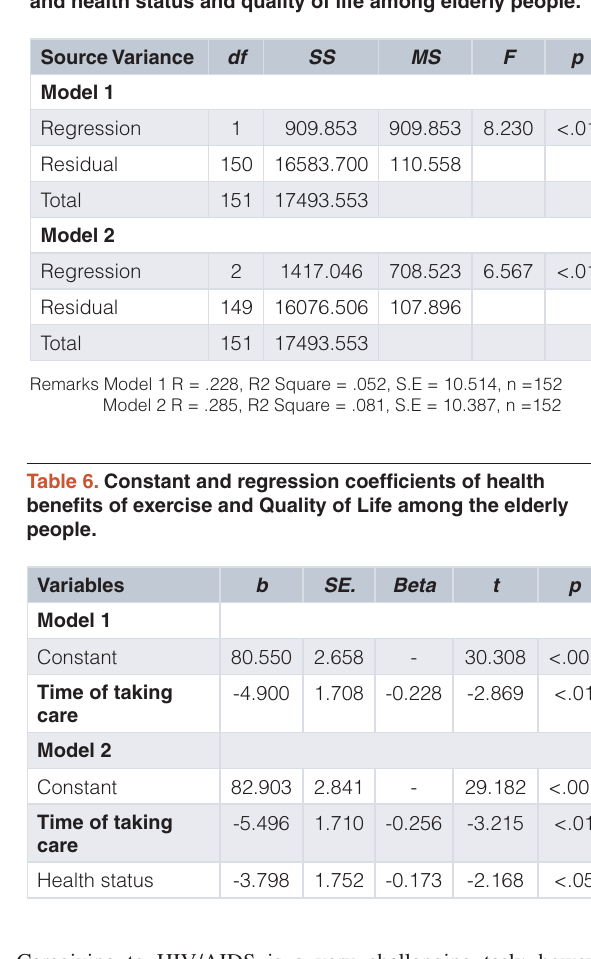
Table 5. Multiple regression prediction of time providing care and health status and quality of life among elderly people.